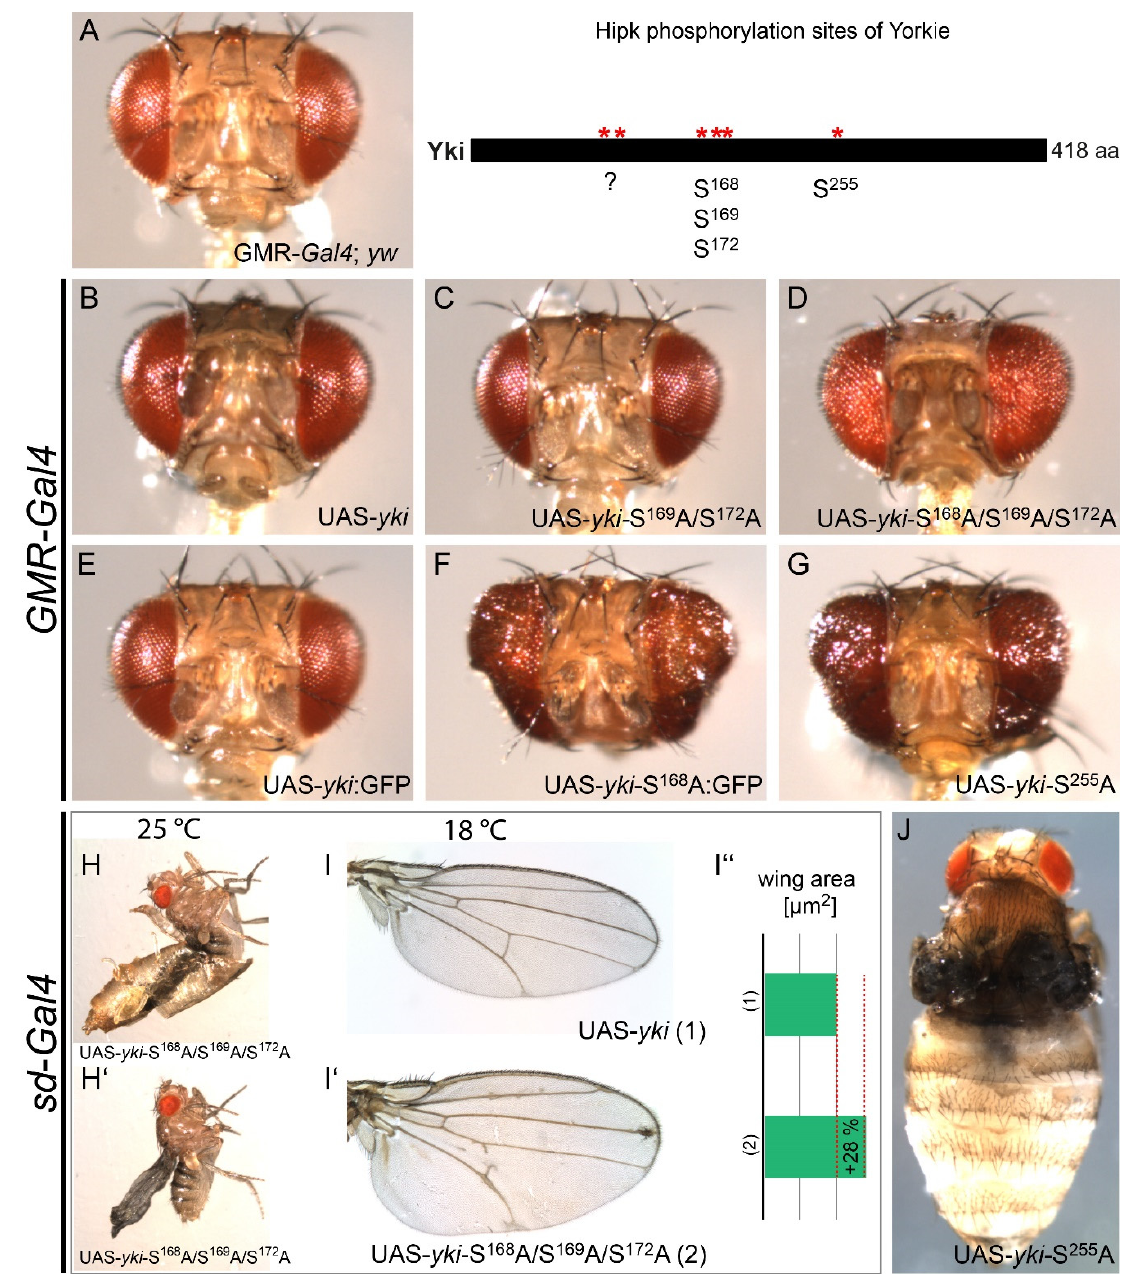
Figure 3. Phosphorylation at Ser169/Ser172 and Ser255 contribute to the Yki activity in vivo. ( A–G ) Heads of adult female flies with the glass multiple reporter ( GMR )- Gal4 and ( A ) no UAS (upstream activation sequence) transgene with a background of yellow white ( yw 67c23 ) (BL 6599), ( B ) UAS- yki , ( C ) UAS- yki- S 169 A/S 172 A, ( D ) UAS- yki- S 168 A/S 169 A/S 172 A, ( E ) UAS- yki :GFP (BL 28815; Oh and Irvine, 2008), ( F ) UAS- yki -S 168 A:GFP (BL 28816; Oh and Irvine, 2008) and ( G ) UAS- yki- S 255 A. ( H–J ) Adult female flies with scalloped ( sd )- Gal4 and ( H , H’ ) UAS- yki- S 168 A/S 169 A/S 172 A (25 ◦ C), ( I ) UAS- yki (18 ◦ C), and ( I’ ) UAS- yki- S 168 A/S 169 A/S 172 A (18 ◦ C); ( I” ) wing area measurements according to I and I’: (1) UAS- yki (female wings, n = 10) with an average area of 2,084,600 µ m 2 , and (2) UAS- yki- S 168 A/S 169 A/S 172 A (female wings, n = 10) with an average area of 2,913,488 µ m 2 ; ( J ) adult female fly with scalloped ( sd )- Gal4 and UAS- yki- S 255 A. The expression of the triple mutant UAS- yki- S 168 A/S 169 A/S 172 A in our assay led to a The eye-specific expression of UAS- yki- S 255 A led to a dramatically overgrown eye phe- rough but only minor overgrown eye phenotype (Figure 3D). The observed phenotypic notype (Figure 3G), implying great Yki activation. To our knowledge, Ser255 is described differences led us to assume that the disruption of the phosphorylation sites Ser169/Ser172 here for the first time as an important site for the regulation of Yki, and our phosphorylation lowers the activity of Yki. As we showed in our in vitro phosphorylation assay that the data allow us to ascribe this regulatory activity, at least partly, to affected residues are Hipk-phosphorylation targets, this milder phenotypical effect might be due to attenuated Hipk signalling. This appears to be supported by the observation of